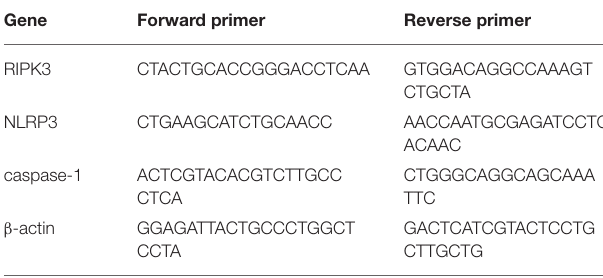
TABLE 1 | Sequences of